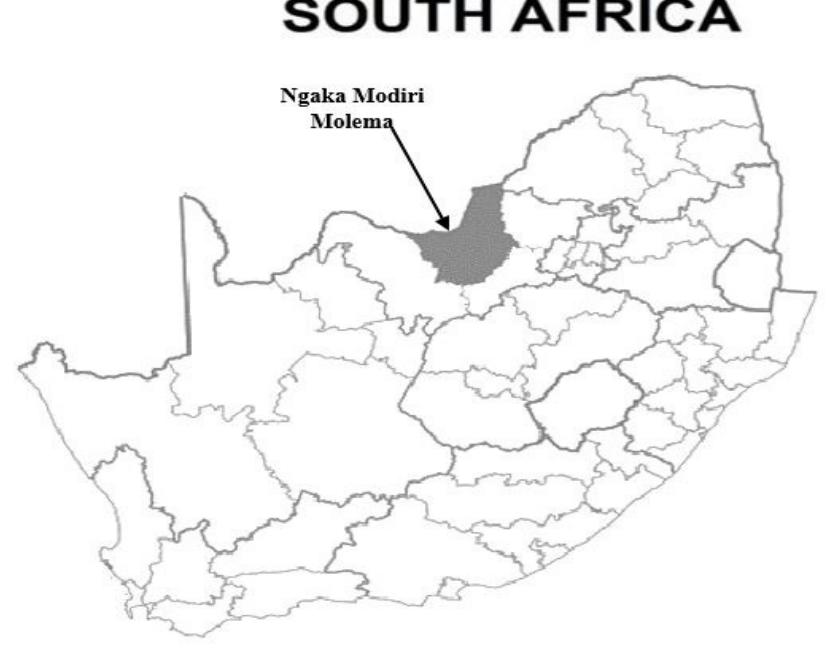
Figure 1. Map indicating the sampling location (Map made with ArcGIS) in the North West province in Ngaka Modiri Molema District Municipality.